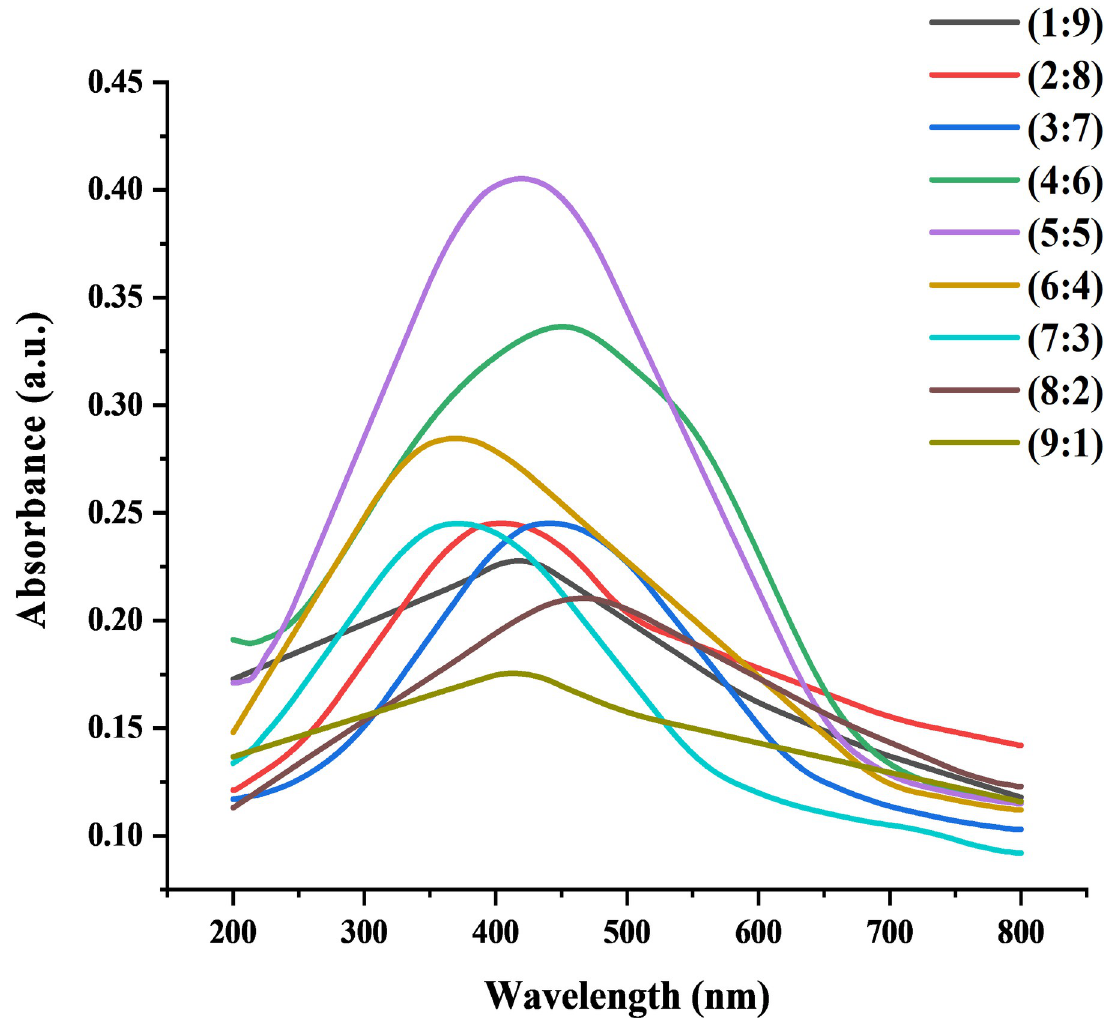
Fig 2. Optimization of AgNPs with different ratio of silver nitrate and ELE